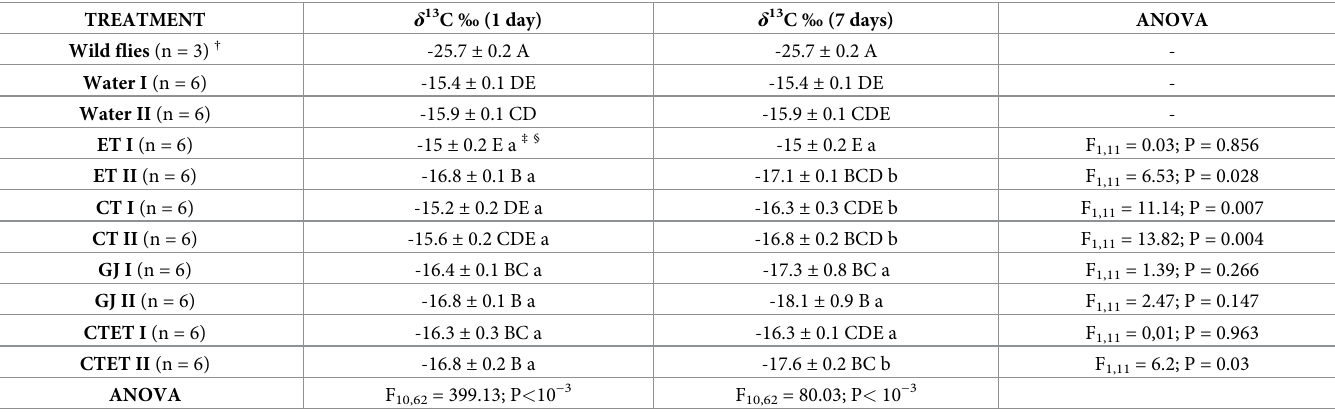
Table 5. Mean δ 13 C values of wild and laboratory Anastrepha fraterculus flies that were immersed in attractive and preservative substances for one and 7 days.